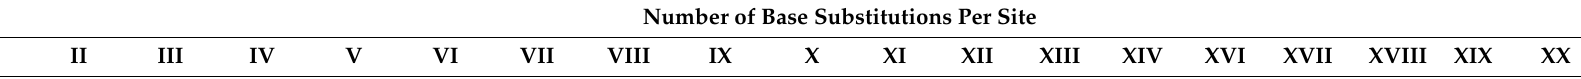
Table 2. Estimates of evolutionary divergence over sequence pairs among genotypes of class II